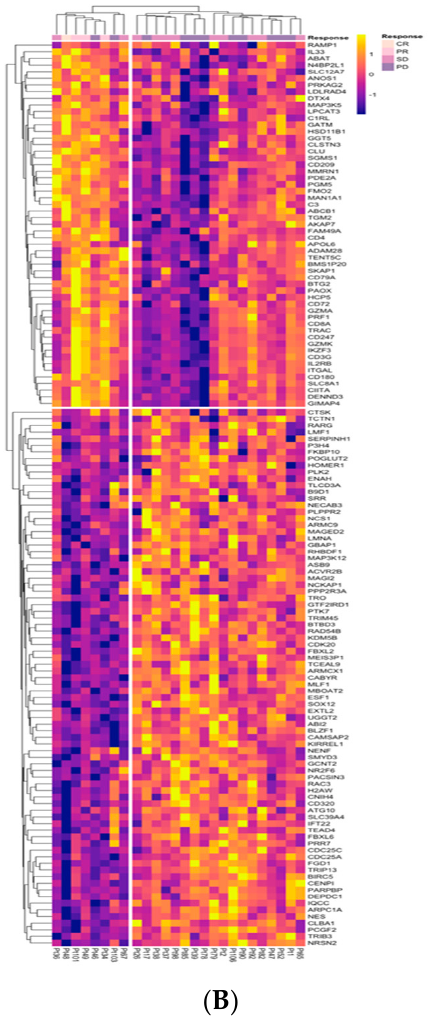
Figure 3. IMMUNETS genes stratify melanoma cohorts by response to nivolumab. Genes shown were found in at most two IMMUNETS networks and were differentially expressed between the response groups in ( A ) MEL_NAI ( n = 23) and ( B ) MEL_PROG ( n = 26). Clinical response is shown (top) and a cluster of responsive patients is found on the left of each heatmap. Blom-transformed gene expression is visualised on a yellow (highest) to blue (lowest) scale, thus lighter colours represent higher expression values.